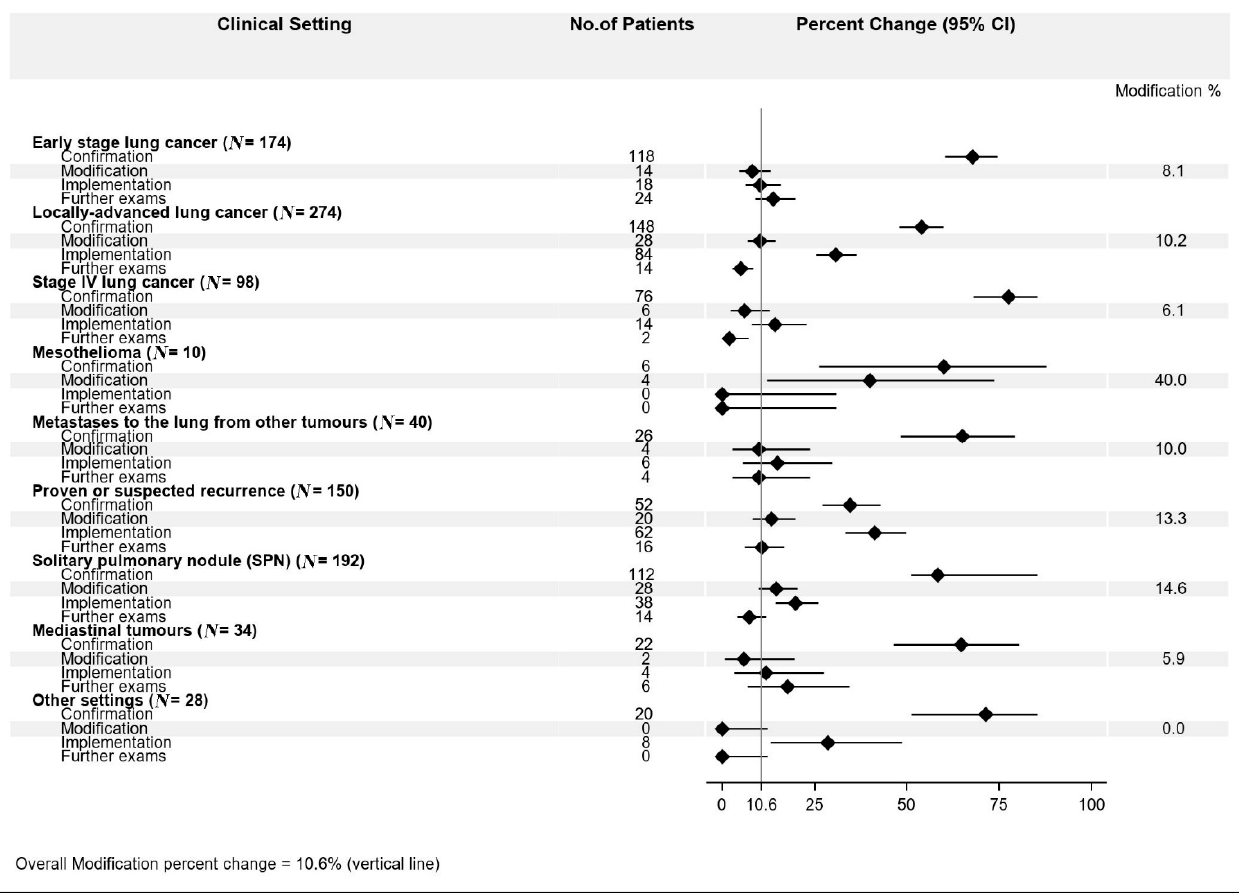
Figure 1. Multidisciplinary team meeting (MDT) impact percent changes according to clinical setting. Table 2. Frequency distribution of histology type by MDT impact, N =